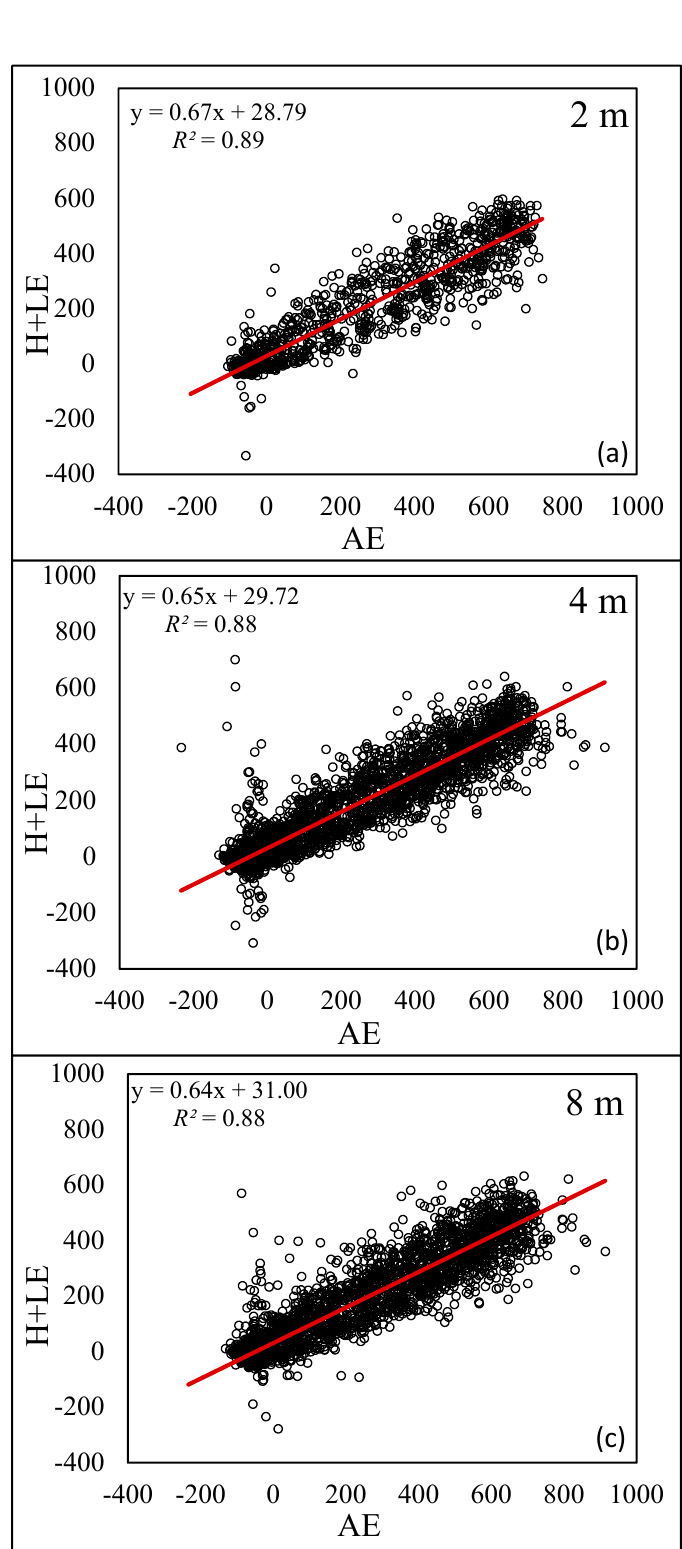
Figure 3. Energy balance closure for the three eddy covariance systems positioned at heights of 2.5 ( a ), 4.5 ( b ), and 8.5 ( c ) m above the soil surface, as indicated by the regression slope between the available energy (AE = R n − G) and the turbulent fluxes (H +